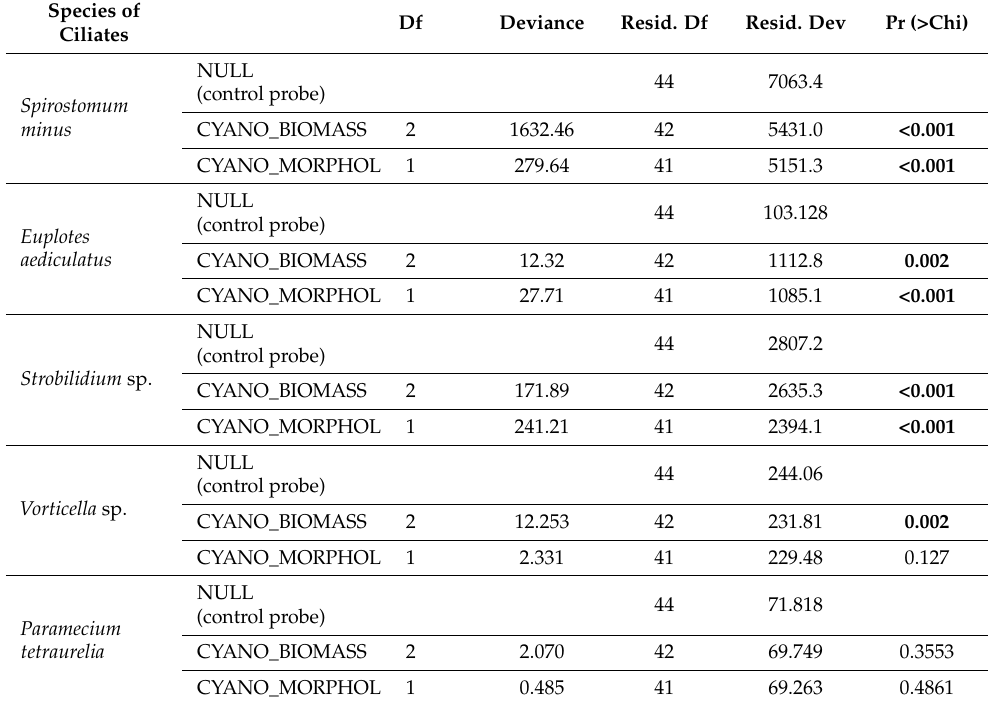
Table 1. Effect of presence of A. flos-aquae total biomass and A. flos-aquae single filaments or aggregates on density of particular species of ciliates, Pr—statistical significances are emboldened. Species of